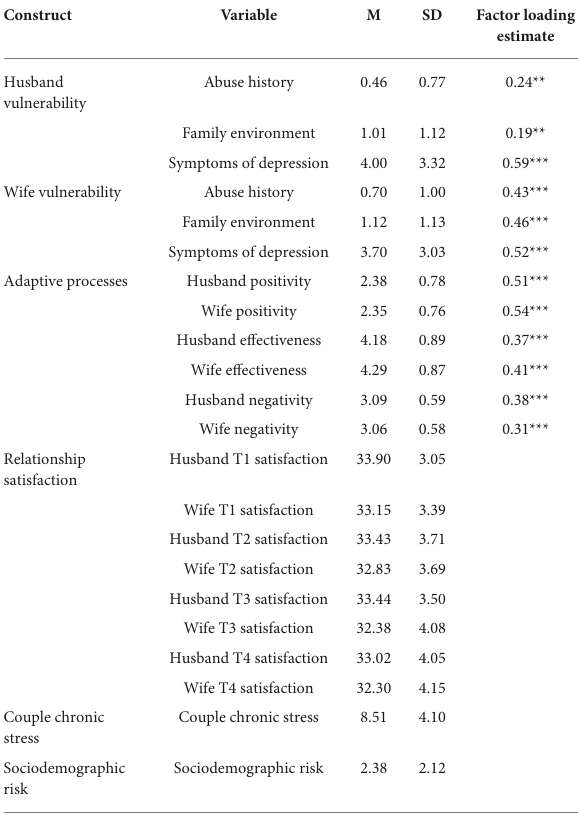
TABLE 1 Descriptive statistics and factor loading estimates for study